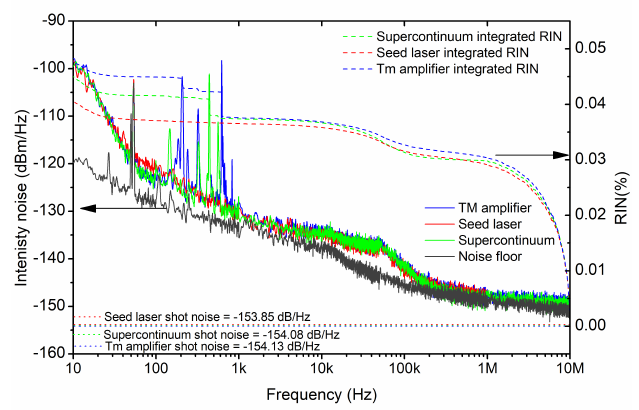
Fig. 1: Measured noise characteristics of the Er:fiber seed laser (red), ANDi supercontinuum (green), and Tm:fiber amplifier (blue) [5]. Fig. 8. Measured noise characteristics of the Tm amplifier (solid blue), Er:fiber seed laser (solid red) and ANDi supercontinuum (solid green). The dotted lines indicate the shot-noise limit corresponding to the Tm amplifier (blue dot), seed laser (red dot) and supercontinuum (green dot). The black continuous line is the noise floor of the photodiode. The right y-axis shows the integrated RIN of the Tm amplifier (blue dash), the Er:fiber seed laser (red dash) and the ANDi supercontinuum (green